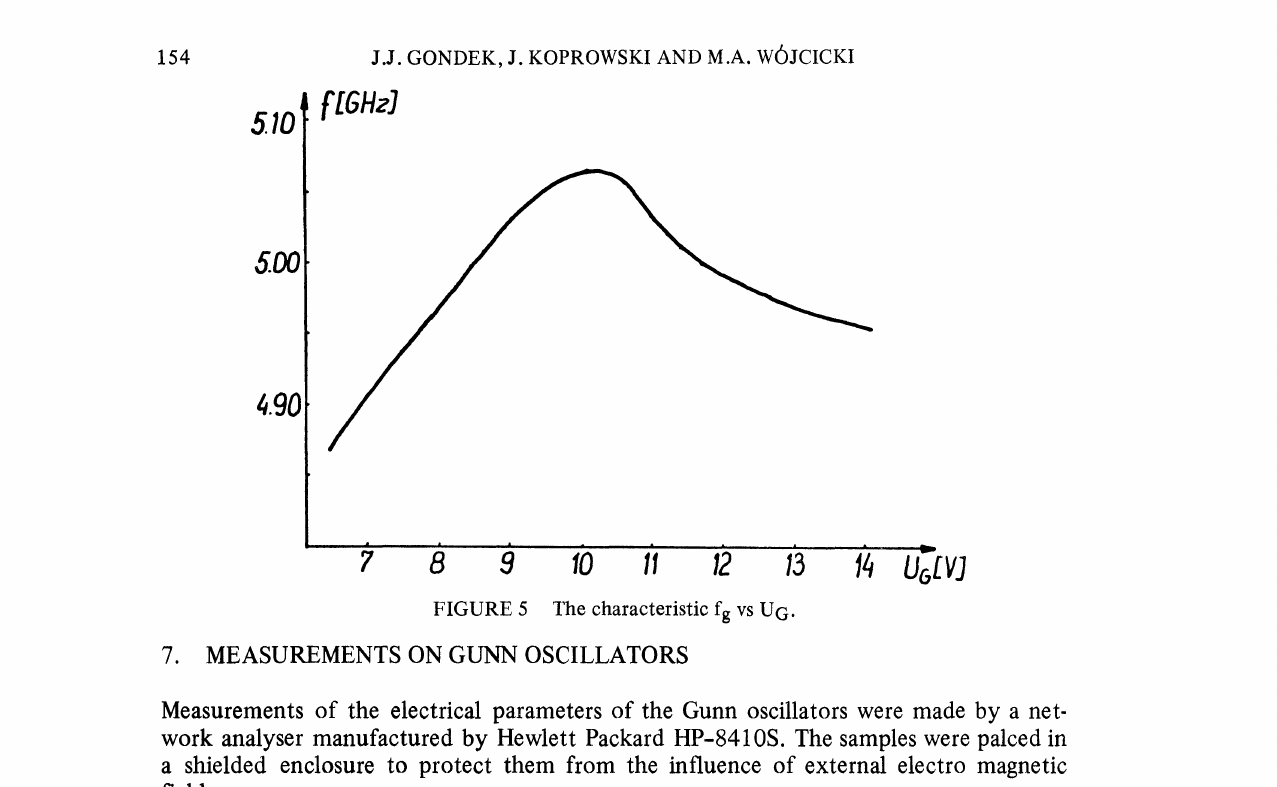
FIGURE 5 The characteristic fg vs UG.